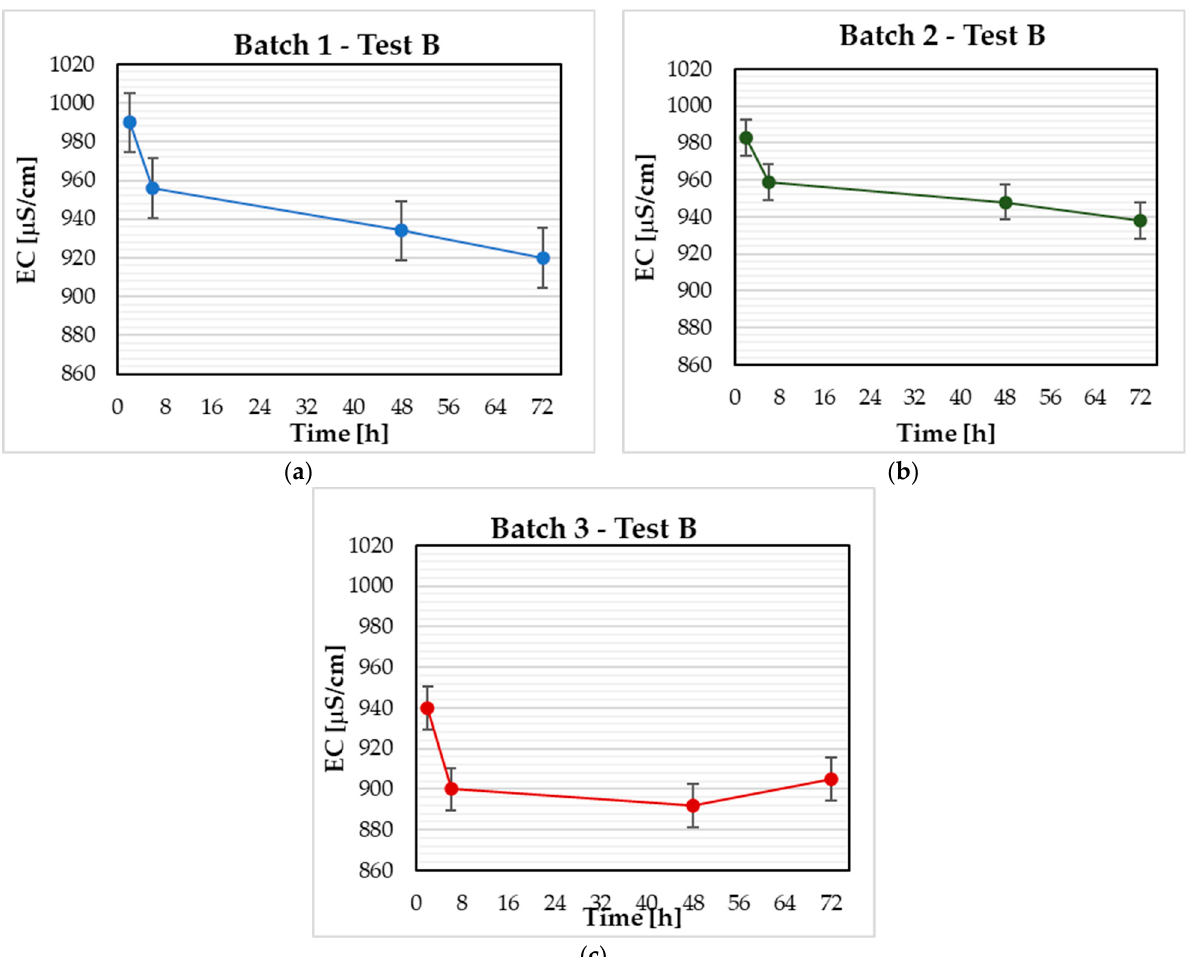
Figure 6. Electrical conductivity trend (Test B): ( a ) Batch 1, ( b ) Batch 2 and ( c ) Batch 3 .